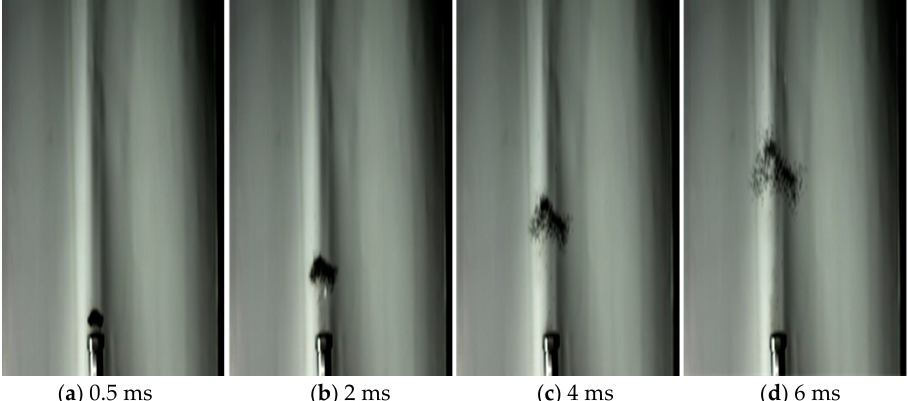
Figure 7. The dispersion process of the quartz sand particles with an average diameter of 0.95 mm during the experiment. ( a ) at 0.5 ms; ( b ) at 2 ms; ( c ) at 4 ms; ( d ) at 6 ms.